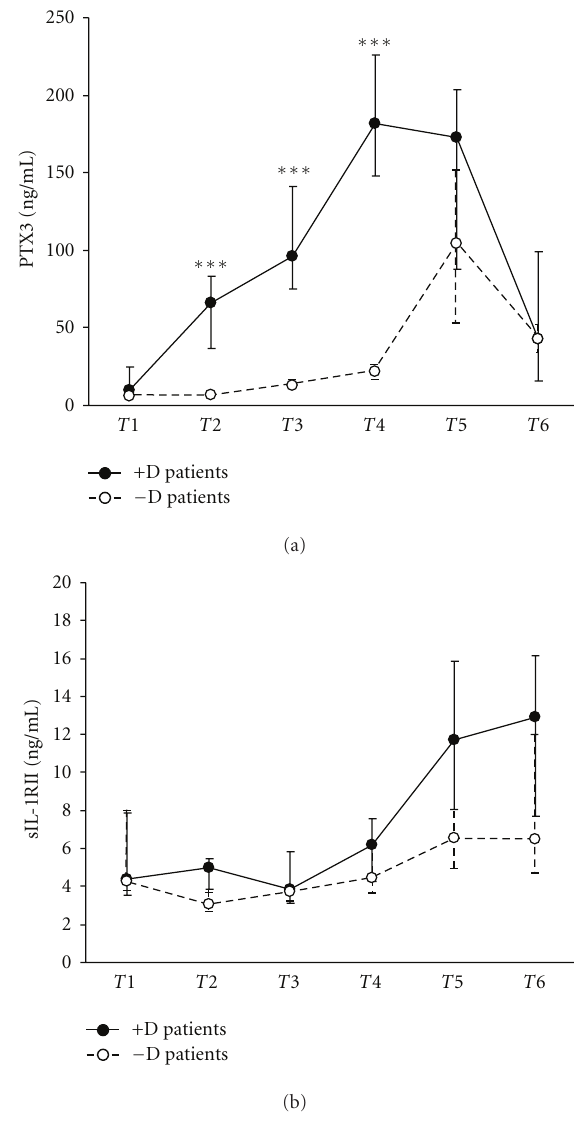
Figure 1: Plasma levels of PTX3 (a) and soluble IL1 receptor II (b) in pediatric patients undergoing CPB, either treated or untreated with dexamethasone. Values are expressed as medians and 1st and 3rd quartile. Time of blood sampling: T 1, preoperative, before steroid administration; T 2, 10min after CPB; T 3, after aortic declamping; T 4, at the end of CPB; T 5, 1st postoperative day; T 6, 2nd postoperative day. ∗∗∗ P < 0 . 001.